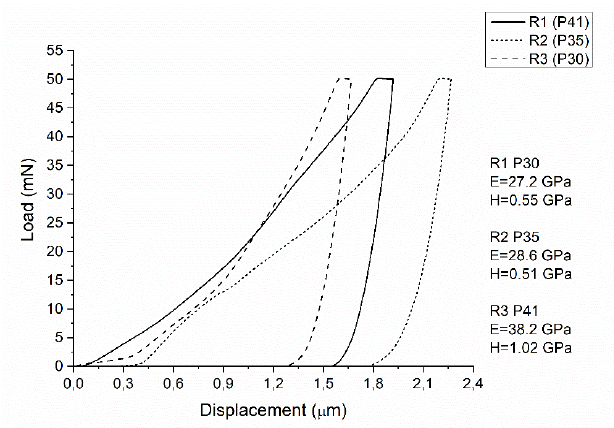
Figure 7. Matrix 2: force versus displacement curves showing representative indentation for each row (R1, R2, R3).